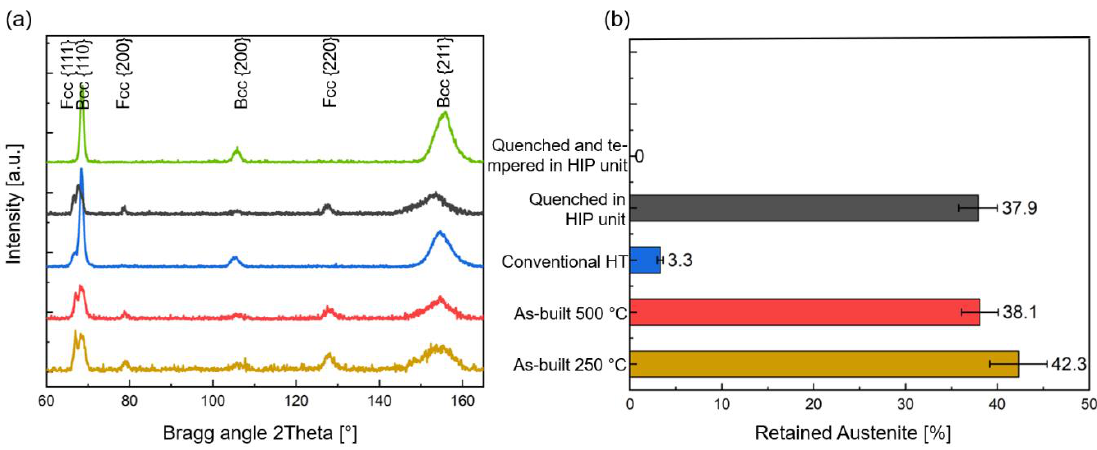
Figure 9. ( a ) XRD phase diffraction pattern and ( b ) retained austenite fraction in different conditions.